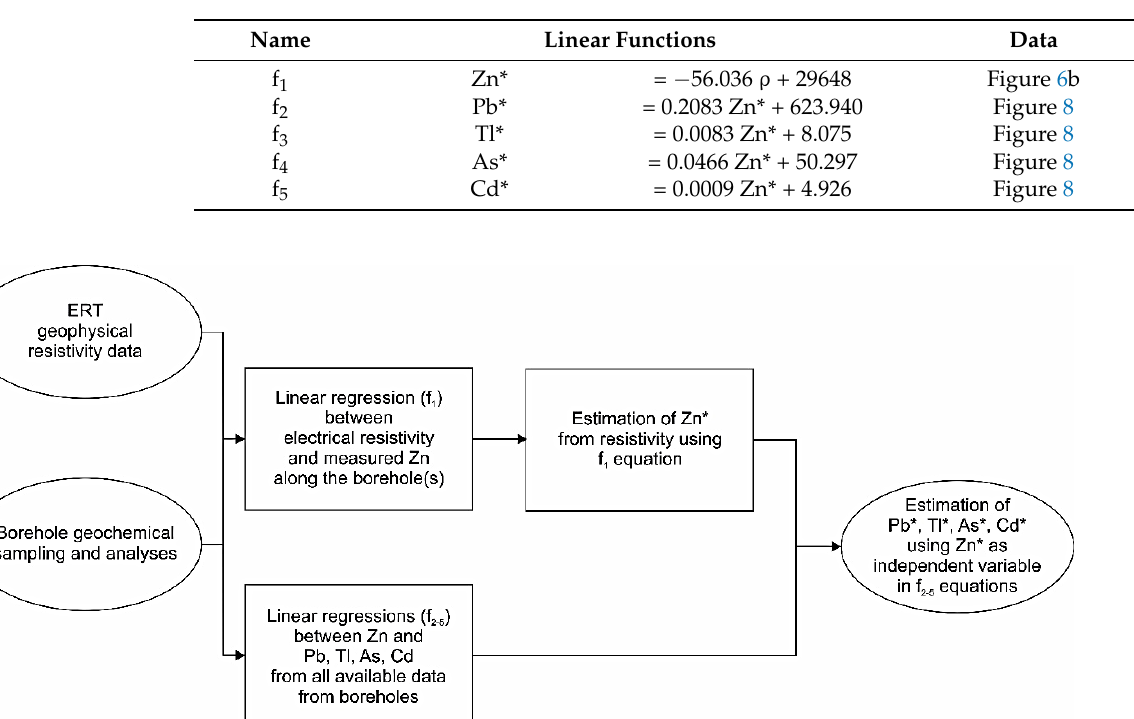
Figure 6. Scatterplots between metal content in the samples from borehole S3 vs. ERT inverted resistivity values. ( a ) Sum ( Σ ) of metals include Zn, Pb, Tl, Cd, Cu, Ni, Sb and Cr whereas only Zn and Pb concentrations are reported in ( b ) and ( c ), respectively.